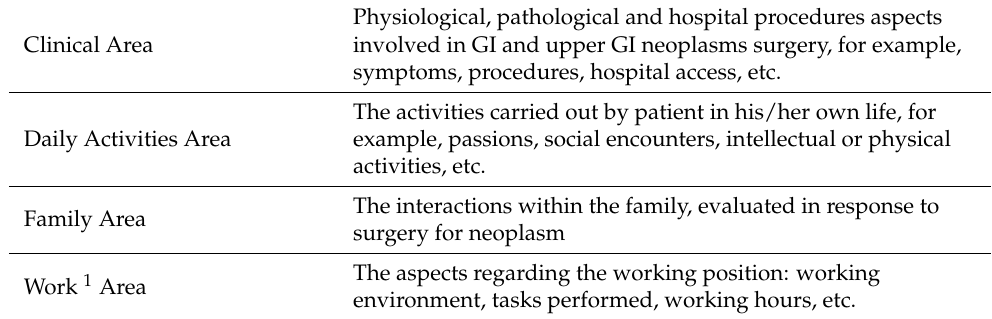
Table 2. Investigation